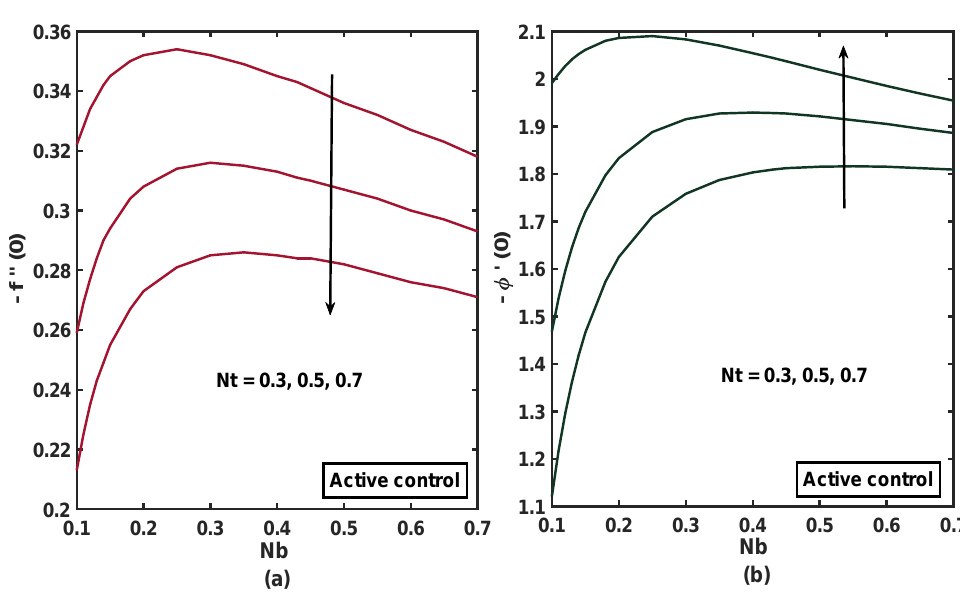
Figure 11. Impact of Brownian motion parameter Nb with varied thermophoresis parameter Nt on ( a ) skin friction coefficient f (cid:48)(cid:48) ( 0 ) and ( b ) mass transfer rate − θ ( 0 )